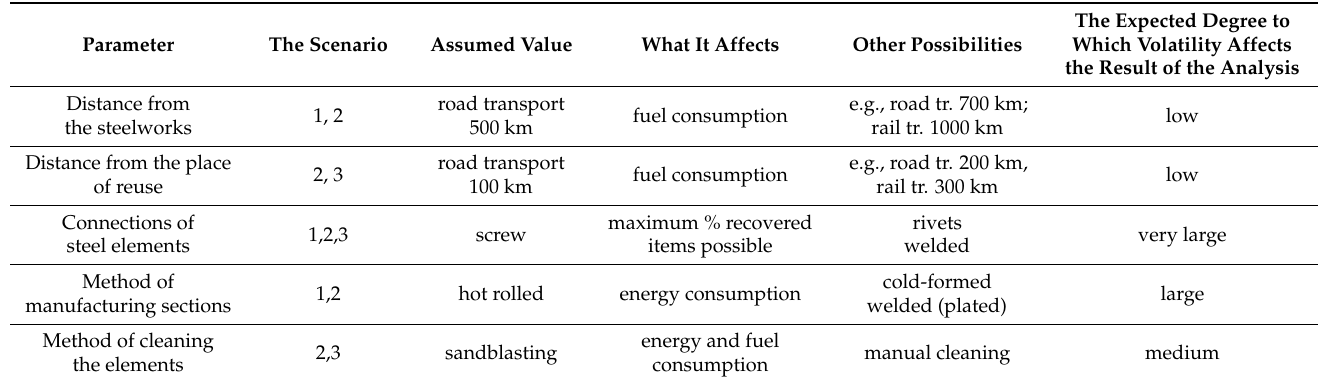
Table 1. Parameters adopted for analysis and the impact of their change on the results.